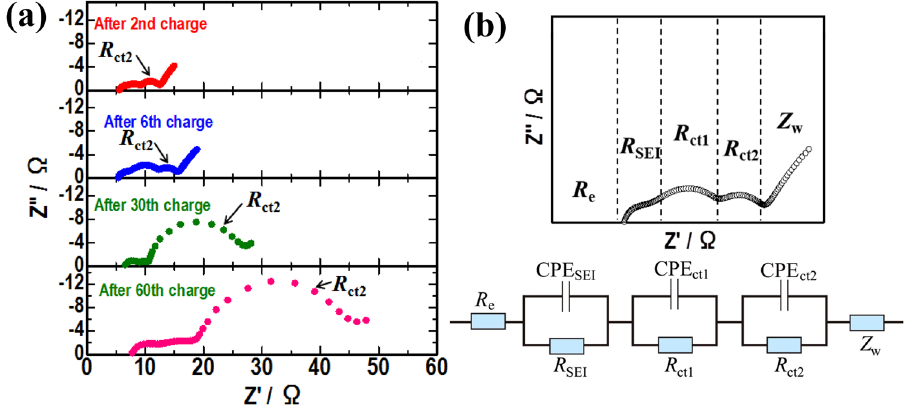
Figure 2. ( a ) Nyquist plots of the cell after the 2nd, 6th, 30th and 60th charge cycles. ( b ) The equivalent circuit was conducted in order to fit the Nyquist plots.